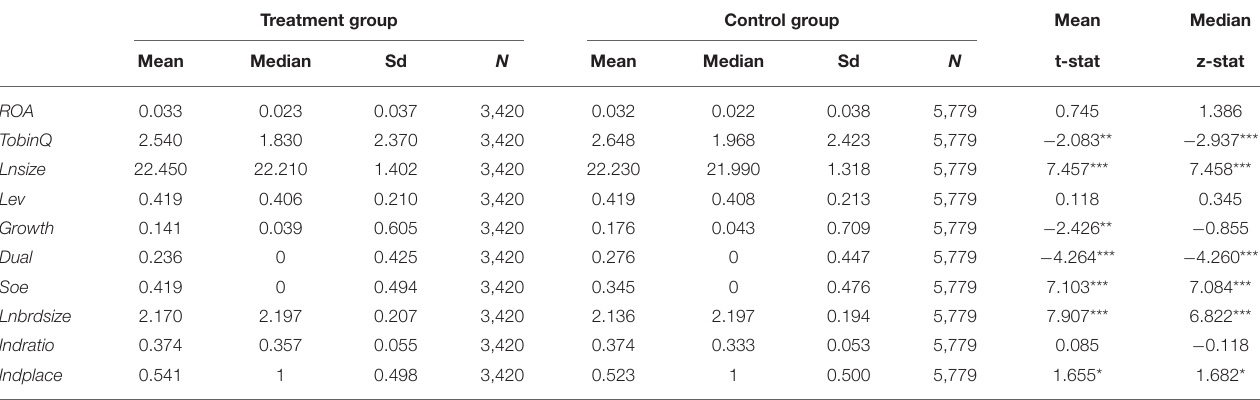
TABLE 4 | Comparative analysis of statistics from 2014 to